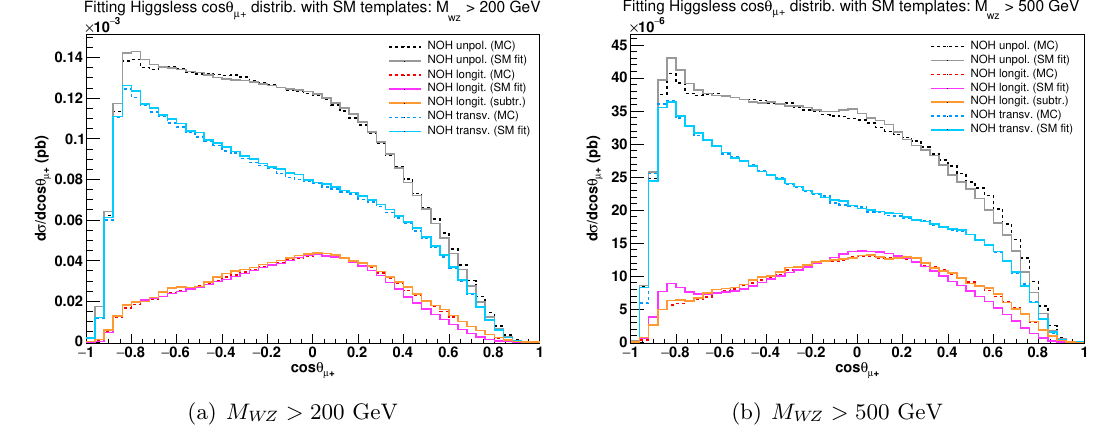
Figure 18 . W + Z scattering: (cid:12)t of Higgsless unpolarized cos (cid:18) Fitted and expected distributions, for M WZ > 200 GeV and M WZ > 500